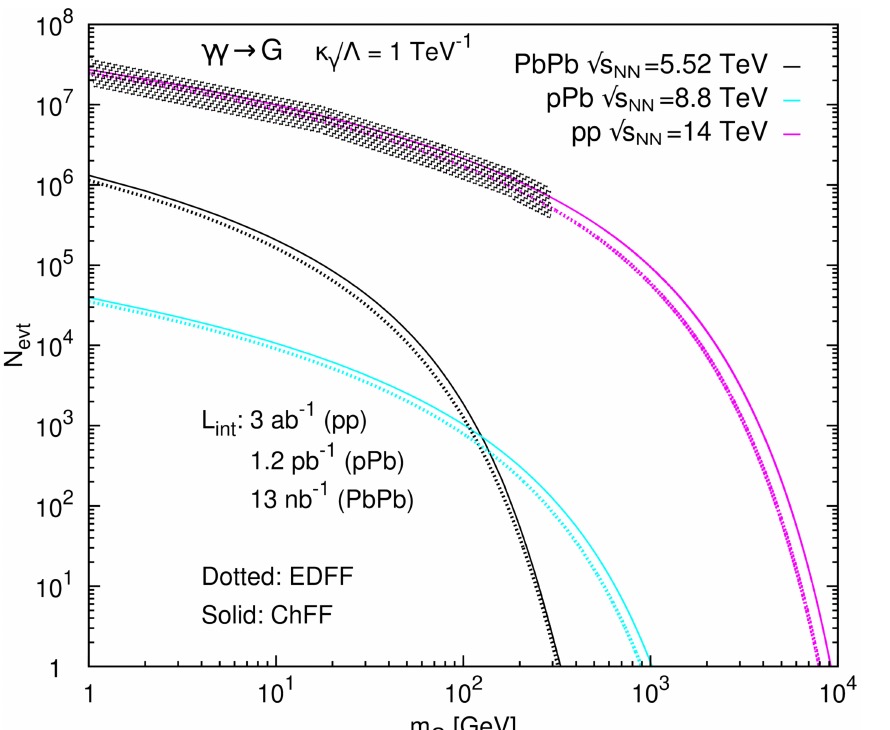
Figure 7 . Total number graviton events expected via (cid:13)(cid:13) ! G in p-p, p-Pb, and Pb-Pb UPCs at the LHC, as a function of graviton mass, for fixed (cid:20) (cid:13) = (cid:3) = 1 TeV (cid:0) 1 graviton-photon coupling computed with EDFF (dotted) and ChFF (solid) (cid:13) fluxes. The hatched area around the p-p curve indicates the range of masses below m G (cid:25) 300 GeV where the detection is hindered due to pileup and lack of proton tagging acceptance. Process, system Scaled CMS data [13] gamma-UPC (cid:27) S tarlight (cid:27) S uperchic (cid:27)